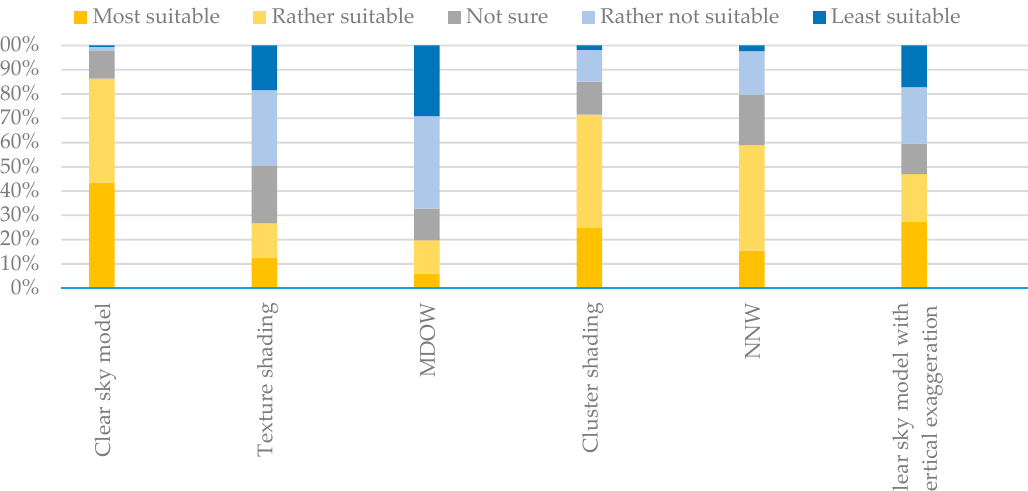
Figure 9. Survey results for mountains formed by erosion processes.